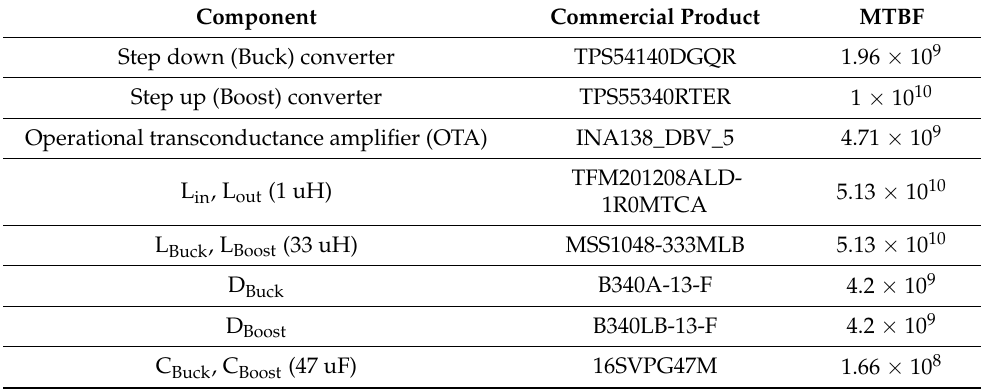
Table A1. Main components of the energy recovery unit of Figure A1